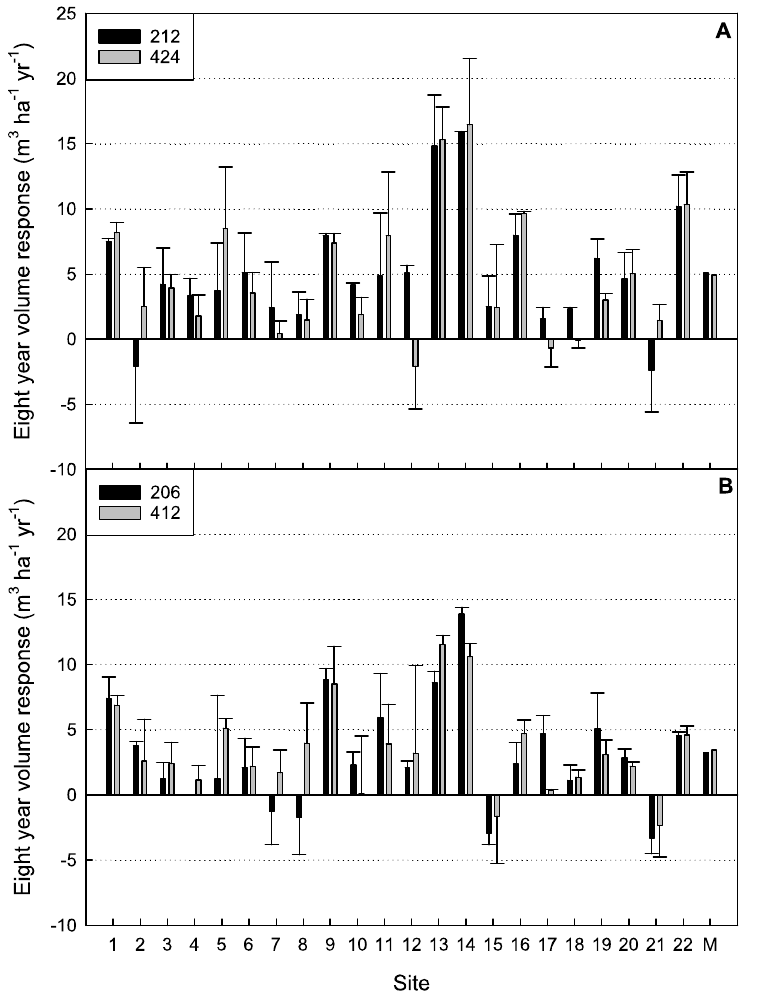
Figure 3. Comparison of treatments where the same cumulative nitrogen dose was applied at different rates and frequency of application across 22 sites in the southeastern United States and the mean (M) across all sites. Panel A shows the comparison where 538 kg ha −1 of nitrogen was applied as four applications of 134 kg ha −1 every two years or as two applications of 269 kg ha −1 every four years. Panel B shows the comparison where 269 kg ha −1 of nitrogen was applied as four applications of 67 kg ha −1 every two years or as two applications of 134 kg ha −1 every four years. Error bars are one standard